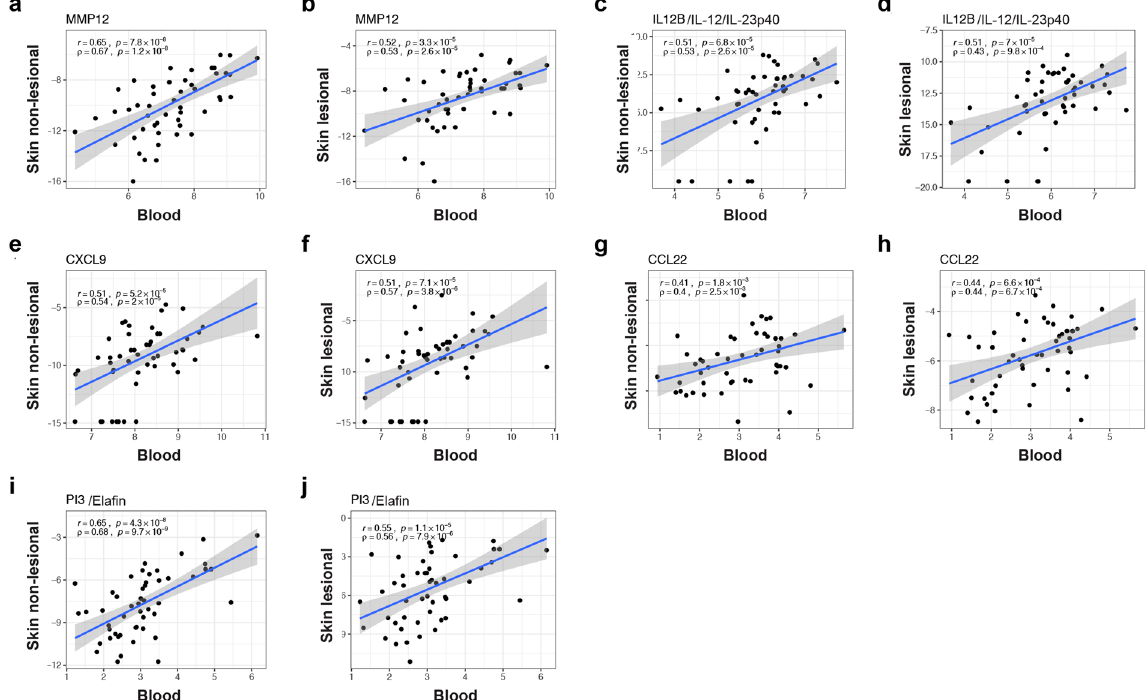
Figure 4. Blood-skin correlations of inflammatory mediators. Correlation plots of selected serum protein levels with their corresponding lesional and non-lesional skin mRNA levels (a – j) ; scatterplots with estimated linear regression and 95% confidence interval; r Pearson correlation; ρ Spearman